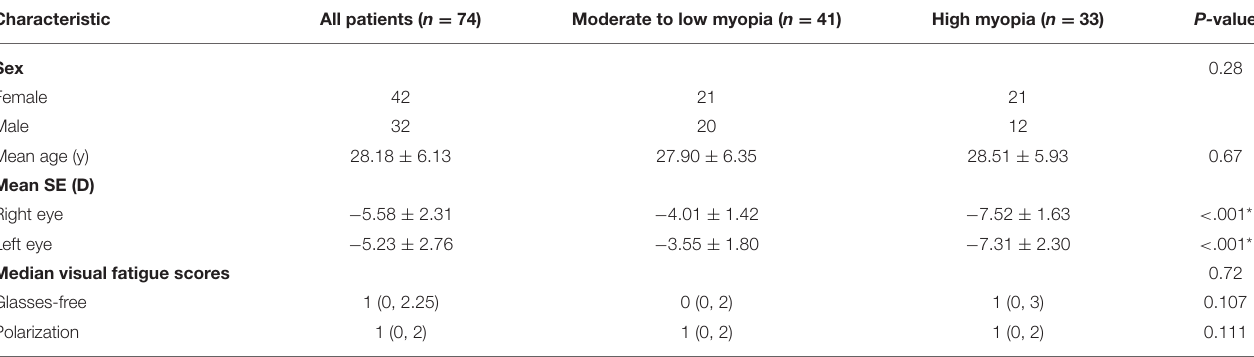
TABLE 1 | Baseline patient characteristics.